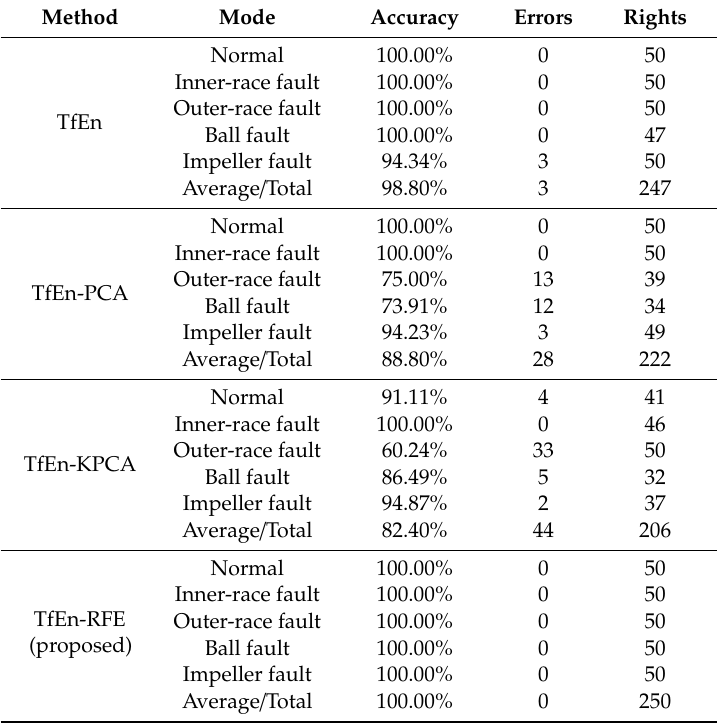
Figure 10. Scatters of total TfEn features ( a ); scatters of optimal TfEn features selected by principal component analysis (PCA) ( b ); scatters of optimal TfEn features selected by kernel PCA (KPCA) ( b ); scatters of optimal TfEn features selected by RFE ( d ). Table 2. Results of proposed fault diagnosis.